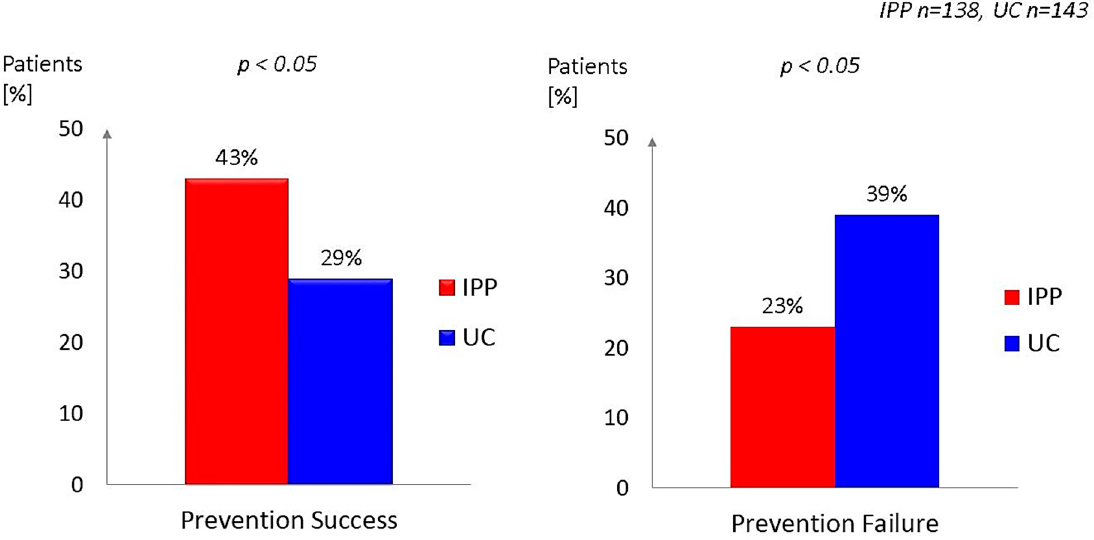
Figure 2. Prevention success and prevention failure associated with 12 months intensive prevention programme (IPP) vs. usual care (UC). Table 1. Definition of the endpoints “prevention success” and “prevention failure” for the IPP study.